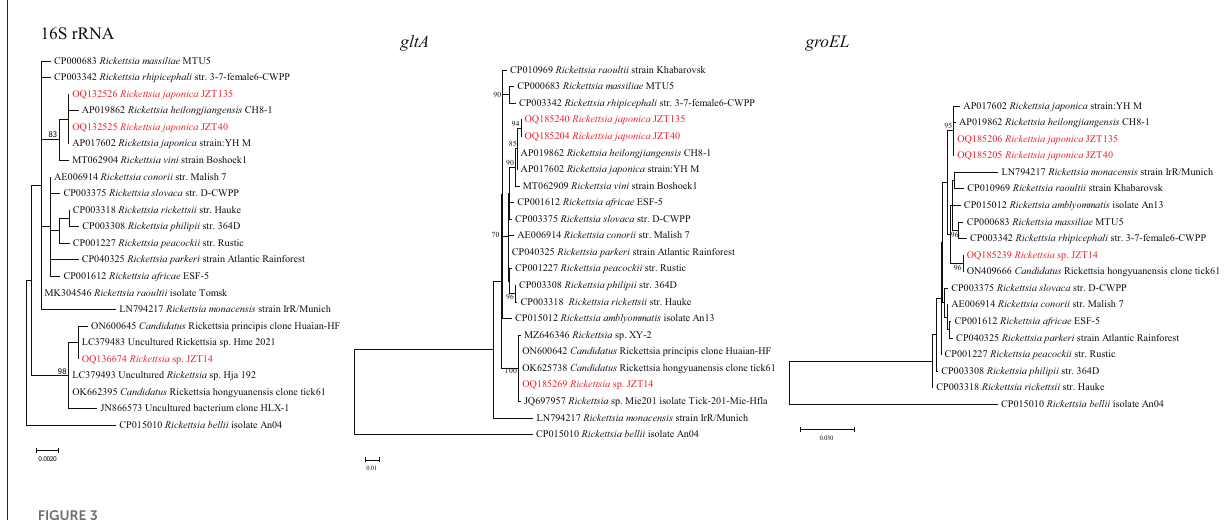
FIGURE3 Phylogenetic trees constructed using PhyML 3.0 based on the nucleotide sequences of the 16S rRNA (1213 bp), gltA (985 bp), and groEL (1051 bp) genes of Rickettsia strains. Sequences obtained in this study are marked in red.